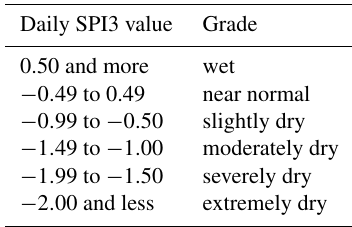
Table 1. Rules for SPI3 grade